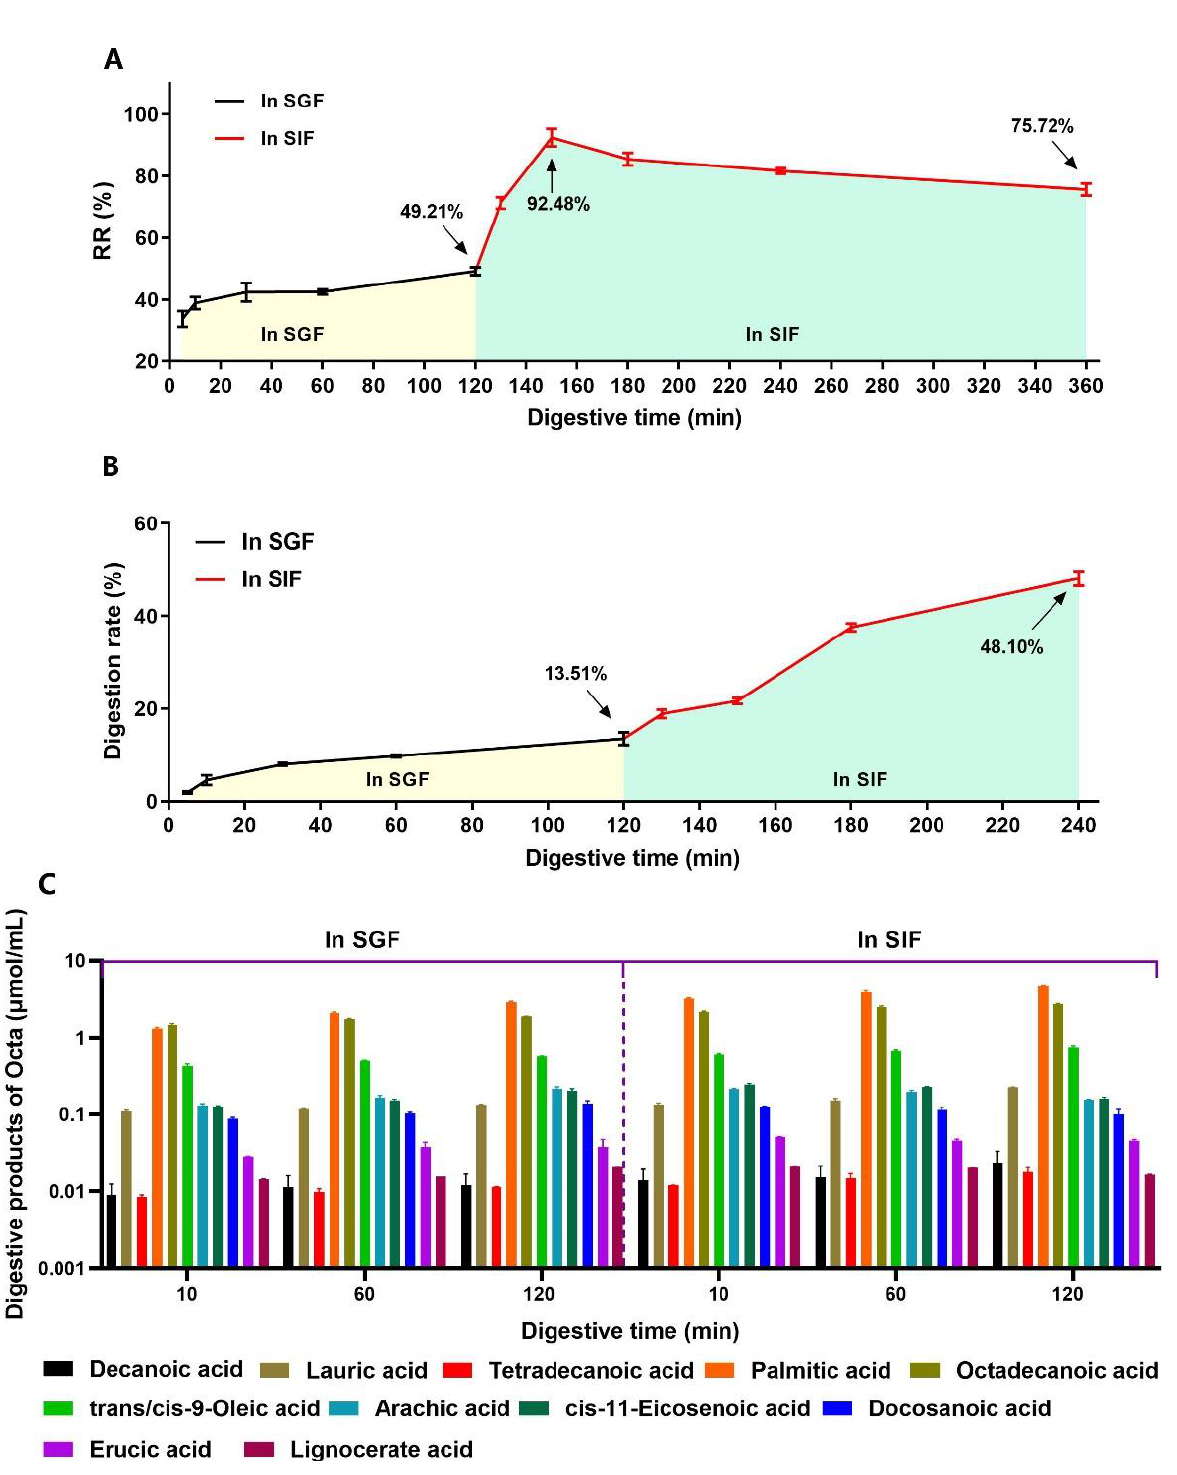
Figure 4. The digestion and the sustained release of Octa in simulated gastrointestinal tract. ( A ) The release rate of Octa from Octa − GA − Malt − PPI microcapsule in in vitro simulated gastrointestinal tract. ( B ) The digestive rate of Octa in in vitro simulated gastrointestinal tract. ( C ) Digestive products of Octa monomer in simulated gastrointestinal tract. The same color indicates the same digestive product.